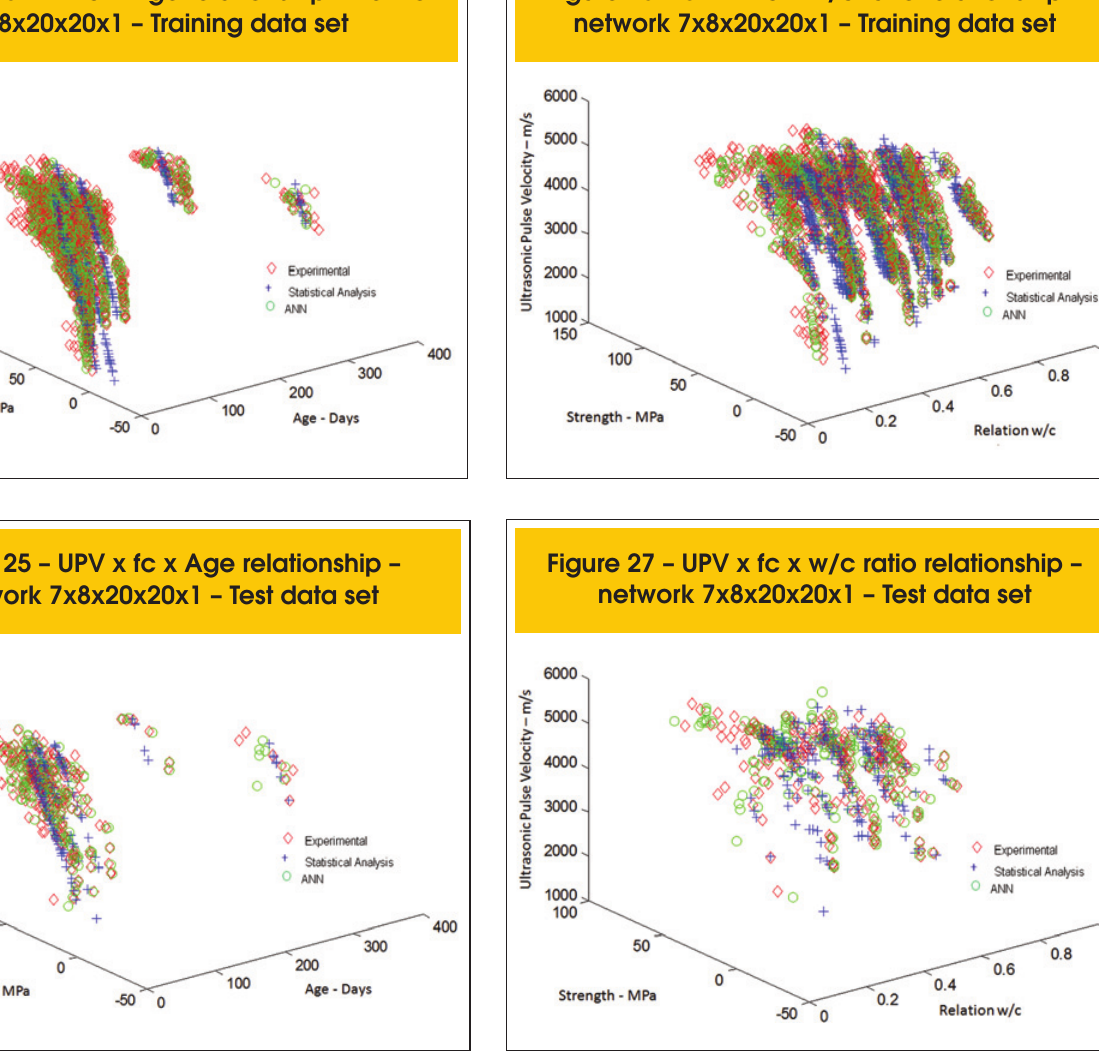
Figure 26 – UPV x fc x w/c ratio relationship – network 7x8x20x20x1 – Training data set